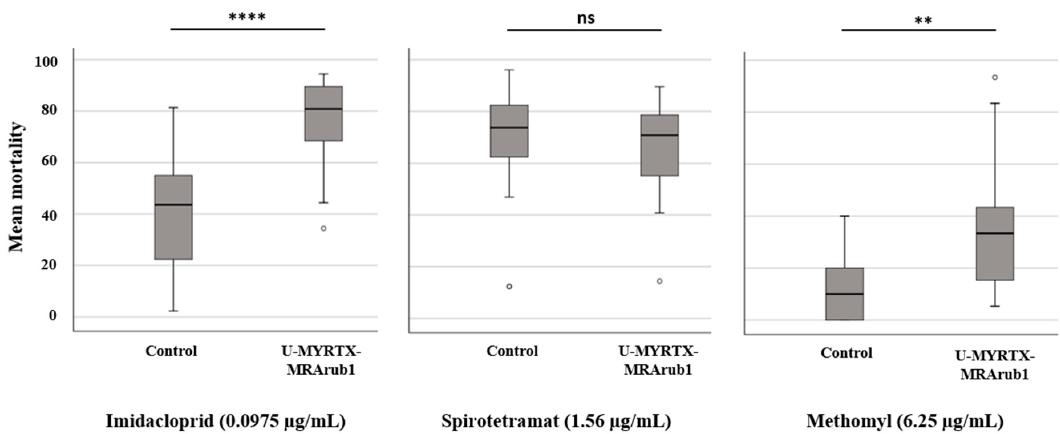
Figure 4. Mortality of A. pisum , previously exposed to feeding treatments (peptide U-MYRTX-MRArub1 and AP3 diet control), following exposure to chemical insecticides (imidacloprid, spirotetramat, and methomyl). Mortality data were evaluated by the Mann-Whitney U test. Statistical data are shown in Table S1. Statistical significance is indicated as follows: ** p < 0.01, **** p < 0.0001. ns, not significant.